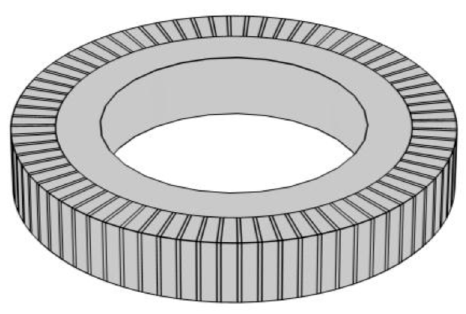
Figure 30. Radial composite piezoelectric ceramic ultrasonic transducer.